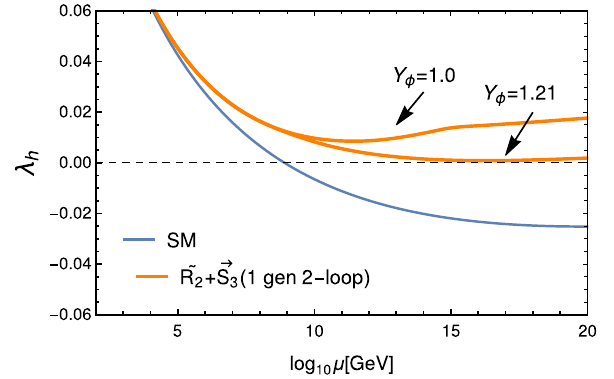
Fig. 12 Higgs quartic coupling running with scale is given for one generationof (cid:2) R 2 + S 3 .Here, λ h runningforSMandone0of (cid:2) R 2 + S 3 are explained by blue and yellow curves, respectively. In order to maintain Planck scale stability, the upper bound on Y φ for this model is 1.21. Here, Y φ includes the leptoquark Yukawa couplings for both (cid:2) R 2 and S 3